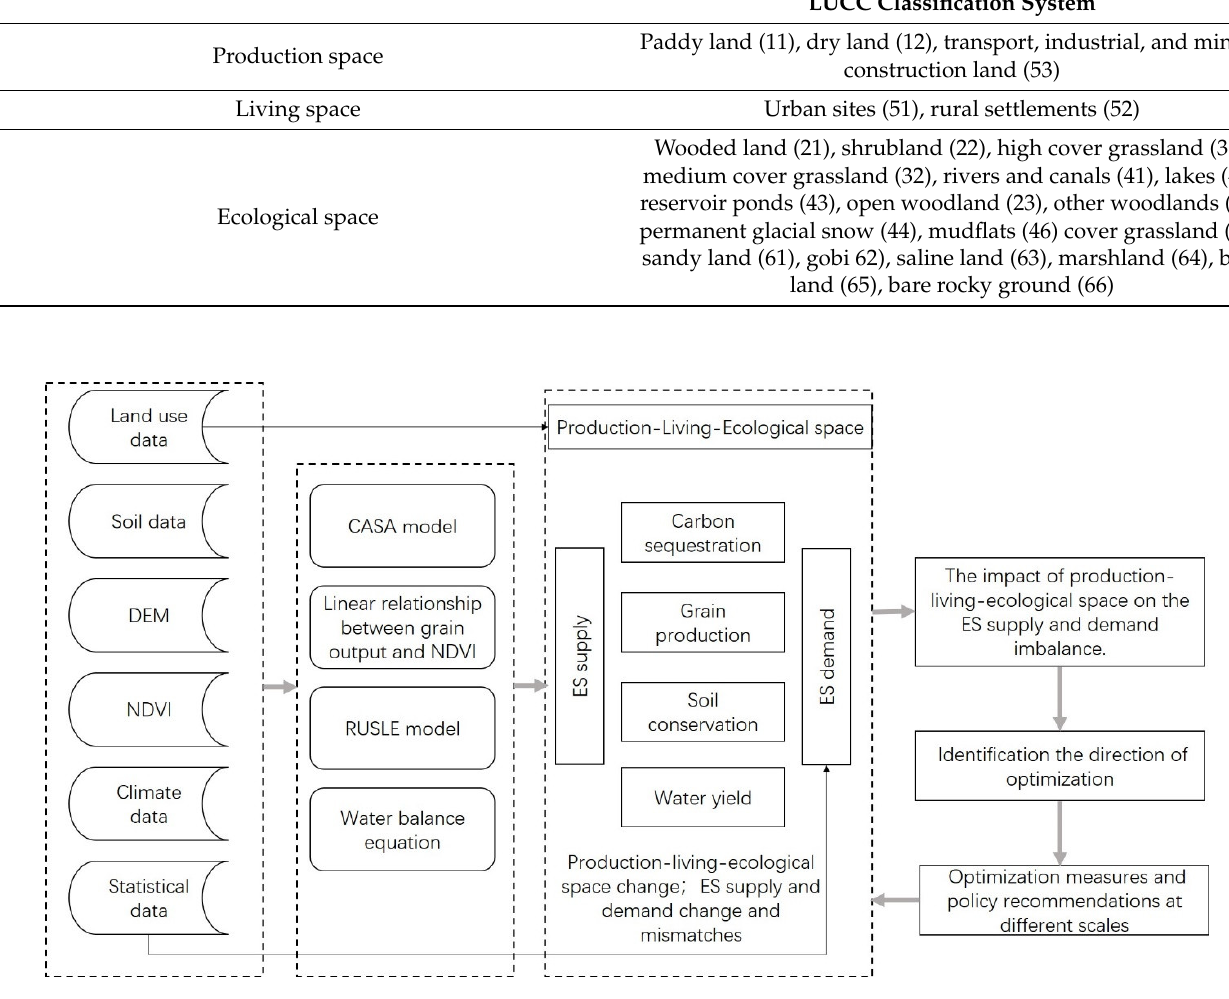
Figure 2. Optimization framework for production-living-ecological space.